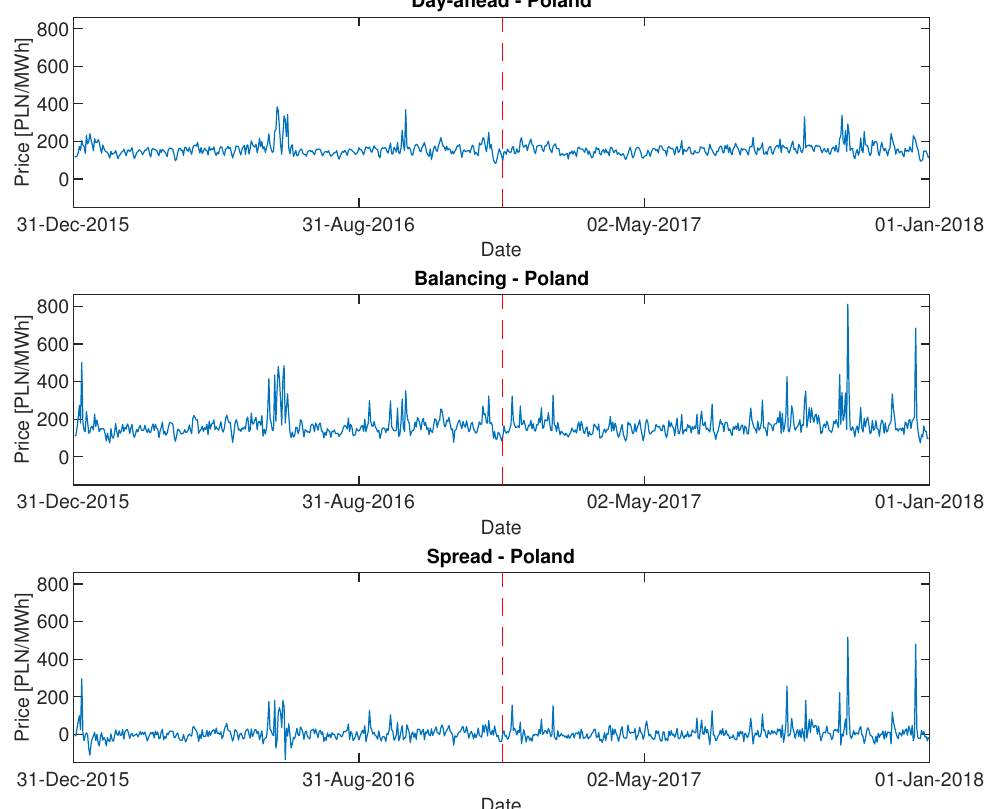
Figure 1. Day-ahead prices, balancing prices, and price spread for Poland with estimation and validation